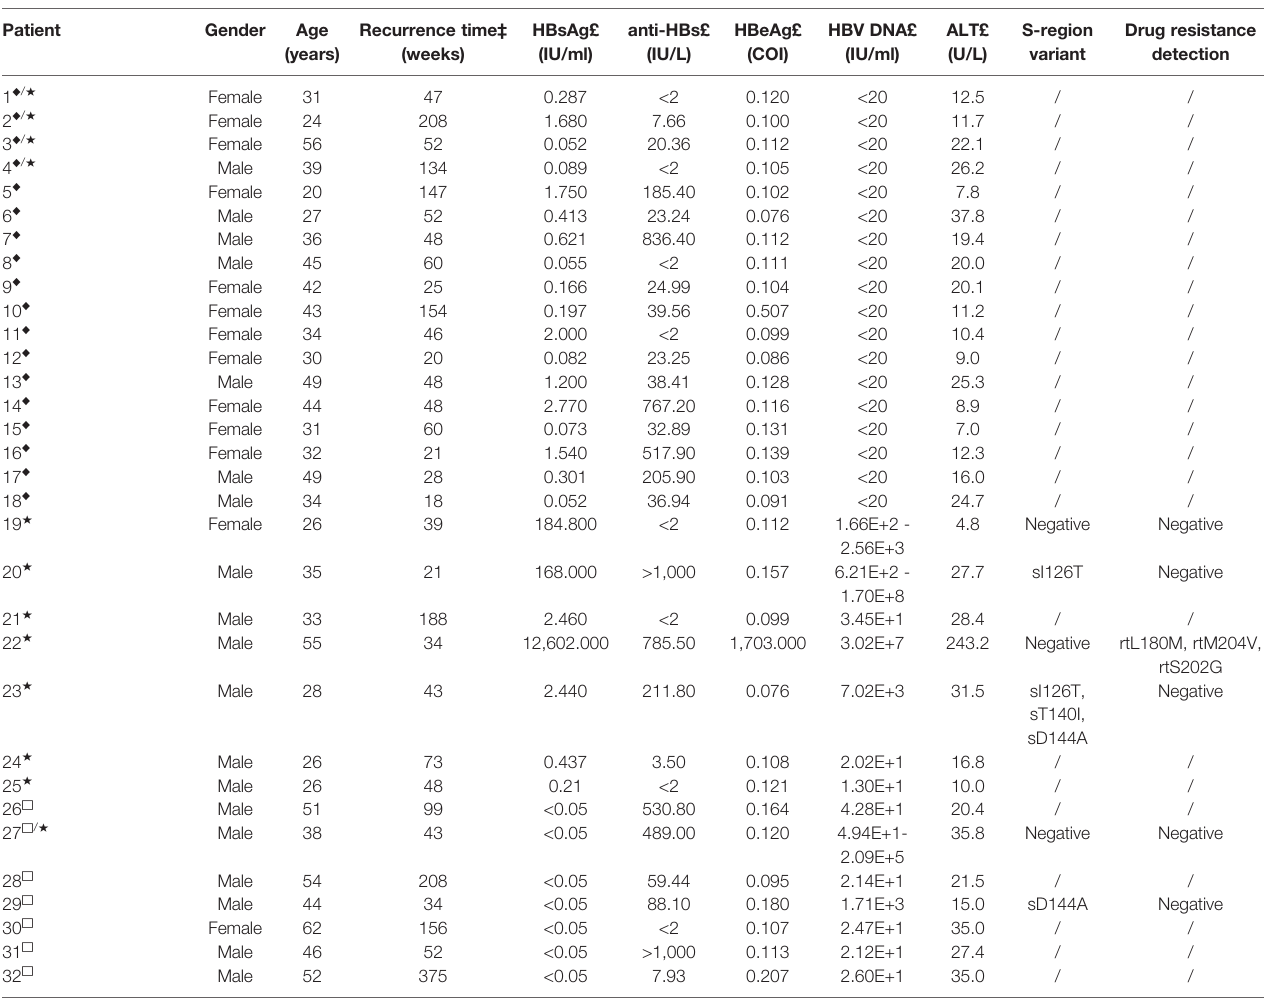
TABLE 1 | Basic information of the 32 patients at the time of recurrence. Patient Gender Age